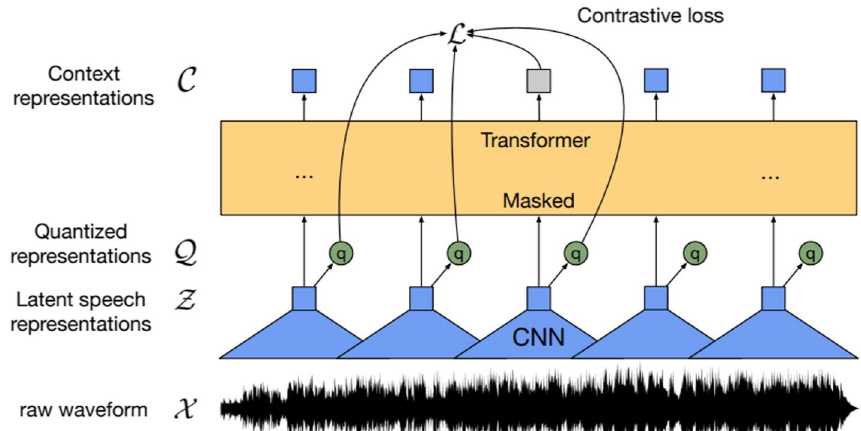
Fig. 4 Structure of the Wav2Vec2.0-based speech model [26]